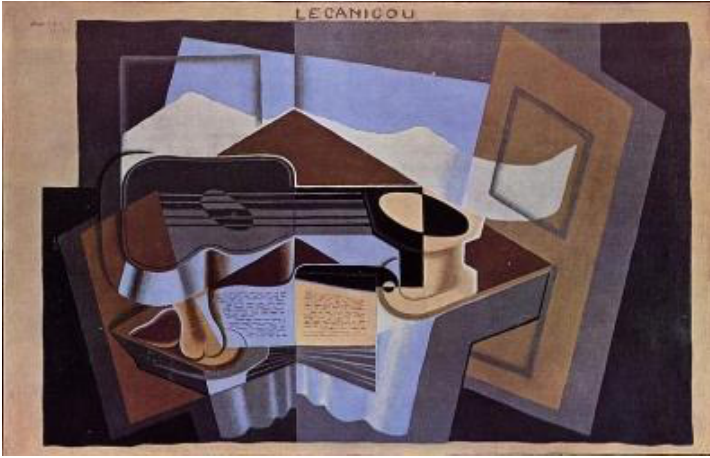
Figure 4. Le Canigou , by Juan Gris, 1921. Oil on canvas, 65 × 100 cm. Albright-Knox Art Gallery ,